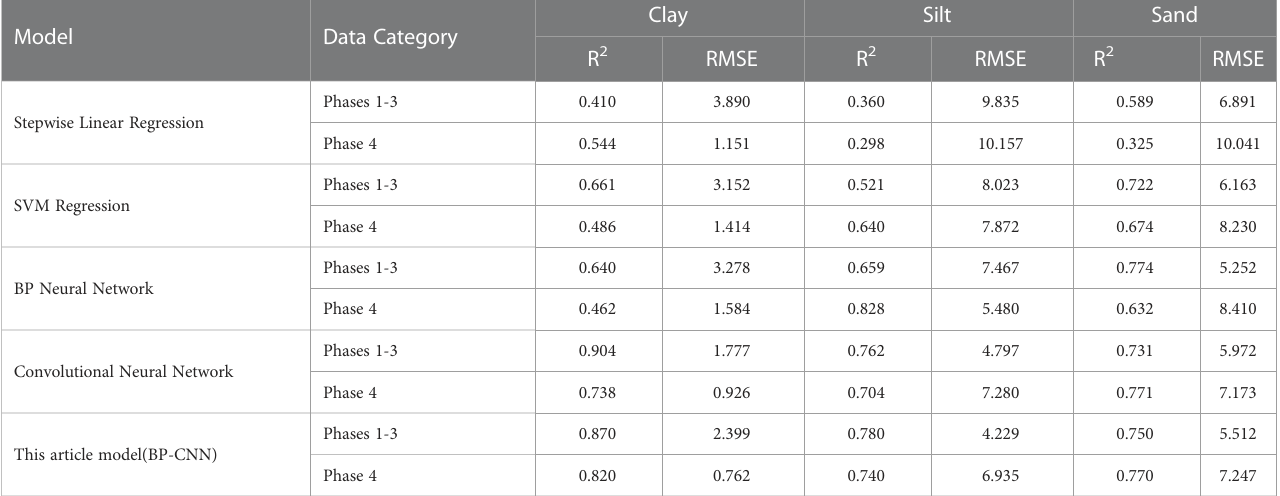
TABLE 3 The accuracy of different methods in tidal fl at sediment composition inversion.